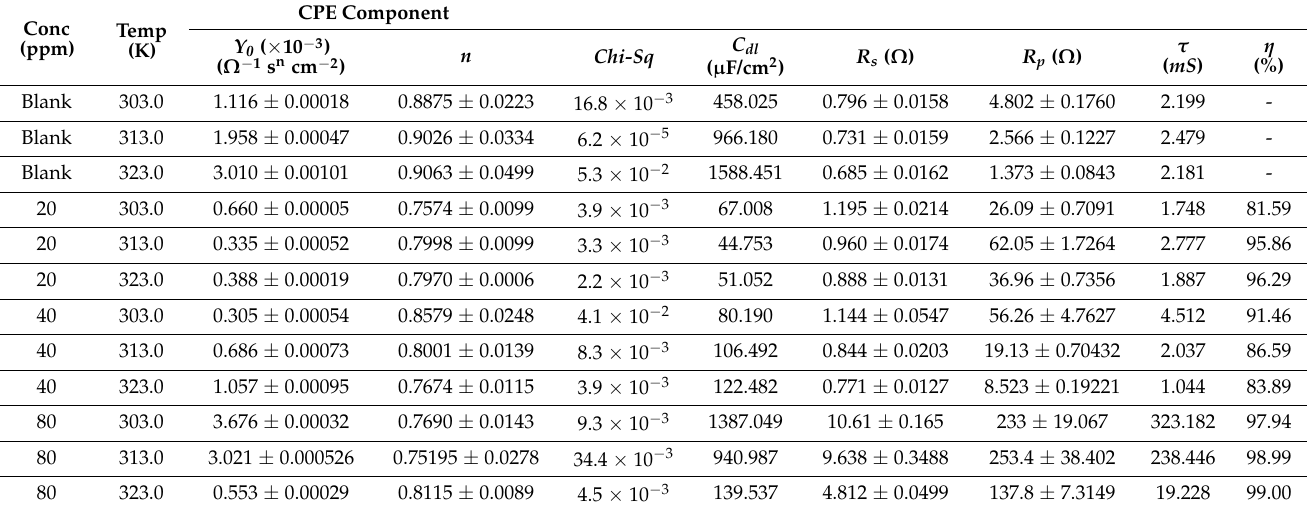
Table 2. The electrochemical parameters of mild steel immersed in the 1 M HCl and in the presence of rice husk ash